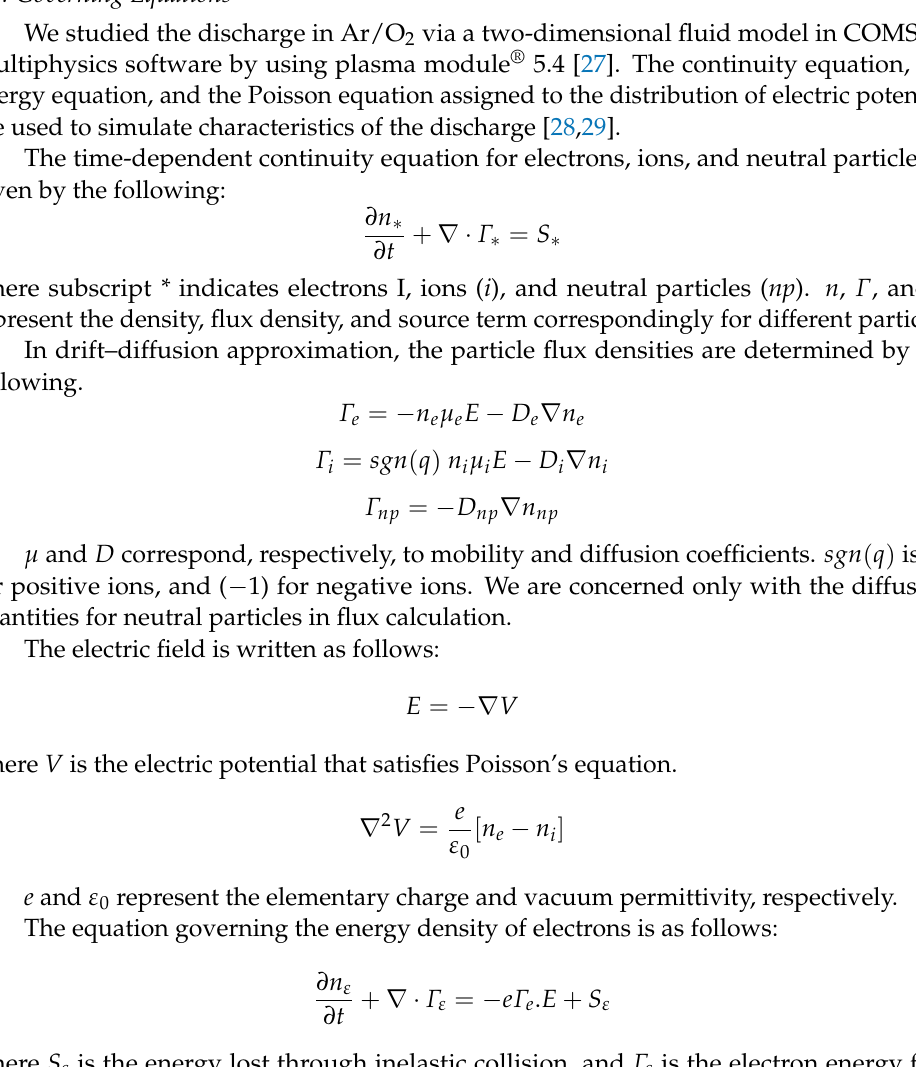
Figure 1. Experimental setup of plasma sterilization using RF capacitively coupled plasma dis- charge.